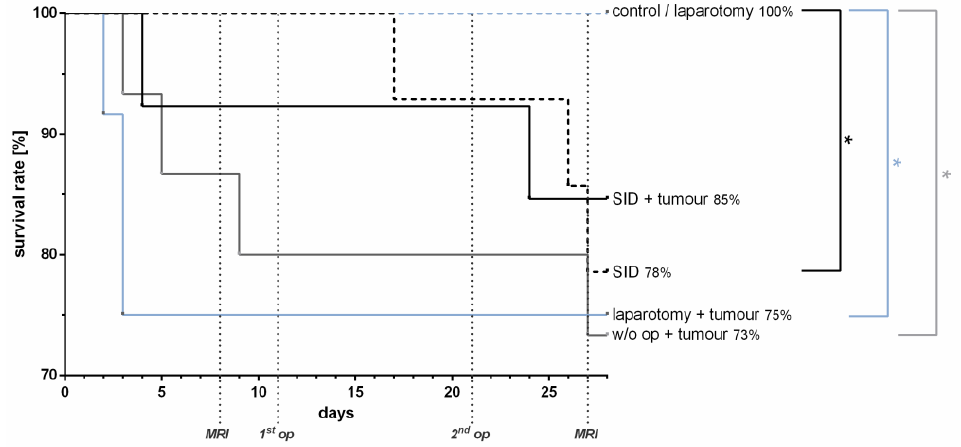
Figure 5. Survival rate. The survival rate was determined by the Kaplan–Meier curve and analysis by the Logrank test. The analysis showed no difference in survival rates between the tumour-bearing groups, whereas in the non-tumour-bearing groups, the survival was significantly reduced in the SID mice vs. control/laparotomy mice (* p ). There was no significant difference in survival between SID with or without tumour, but between laparotomy + tumour vs. laparotomy (* p ) and w/o op + tumour vs. control (* p ). n = 12 – 15 (SID + tumour: n = 13; laparotomy + tumour: 12; w/o op + tumour/SID/laparotomy/control: 15); * p < 0.05.